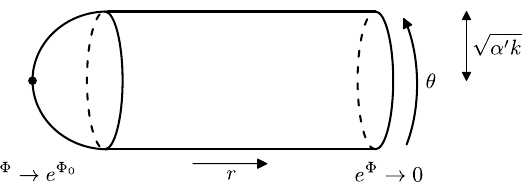
Figure 1. The cigar background. The cigar sigma-model is a weakly-coupled Lagrangian descrip- tion of the SL(2 , R ) k / U(1) CFT when k is large. For large r , the geometry is a cylinder of radius √ α 0 k , and as r → 0 the cylinder smoothly caps off. The dilaton is a monotonically decreasing function of r . Its maximal value Φ 0 is attained at the tip, and at large r it falls off linearly as − r . Although a string in the weak-coupling region appears to be able to wind around the cylinder, there is no conserved topological charge because the string can unwind at the